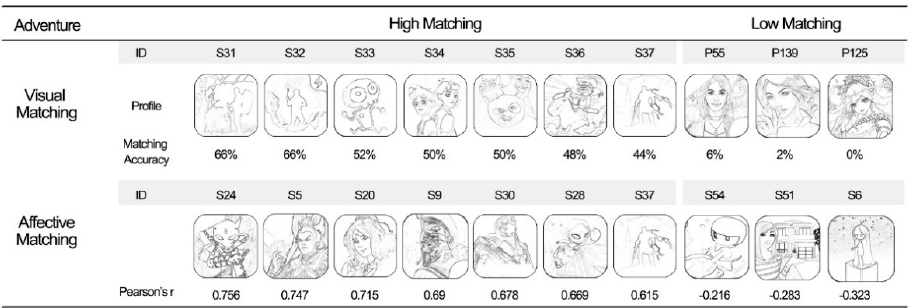
Figure 8. Adventure game icons with high perceptual matching.